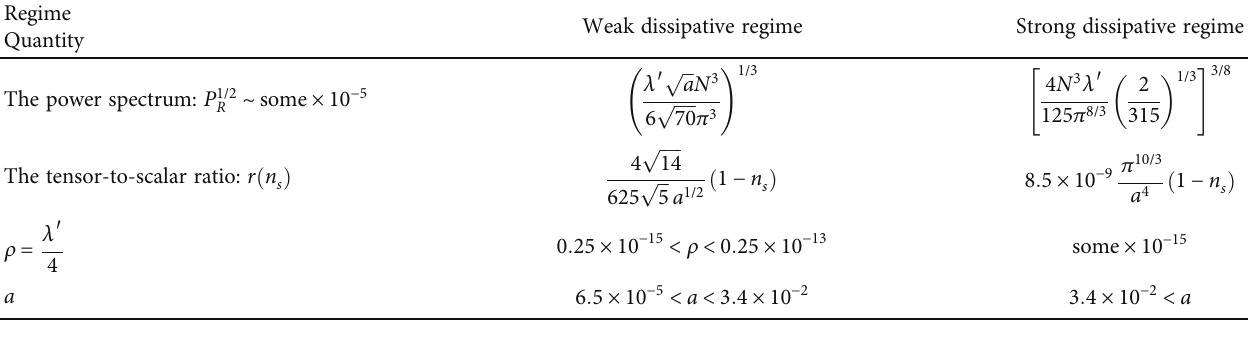
Table 1: The values of quantities are calculated to give the result r ð n Regime